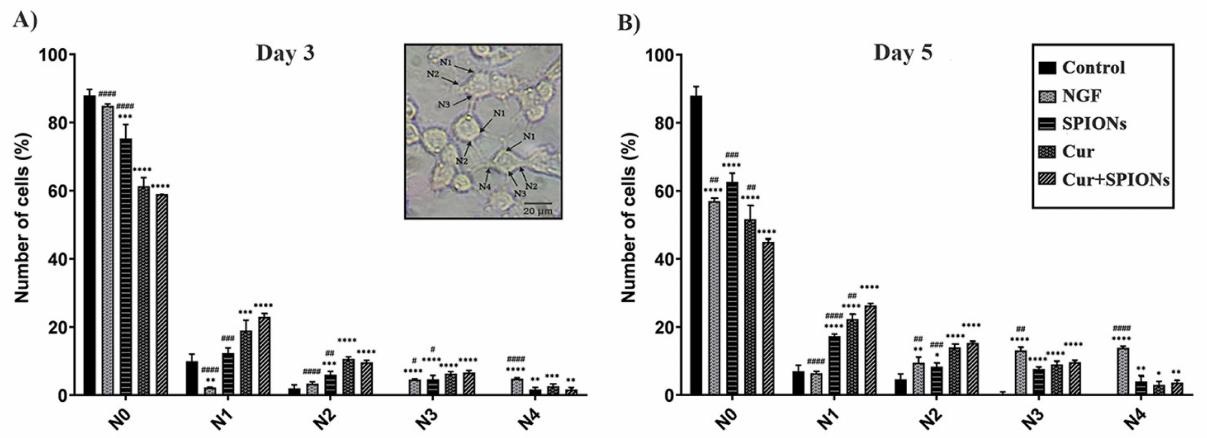
Figure 5. Effects of NGF, SPIONs, curcumin, and Cur+SPIONs on neurite outgrowth in PC12 cells. The number of neurites originating from the soma ( A ) 3 days and ( B ) 5 days after treatment with NGF (50 ng/mL), SPIONs (20 µ g/mL), curcumin (20 µ M), and Cur+SPIONs and the concentration of Cur was 20 µ M in each combination Cur+SPIONs, and the concentration of SPIONs was also 20 µ g/mL. Arrowhead indicates the number of neurites originating from the soma in cells treated with Cur+SPIONs. (#, * p < 0.05, ##, ** p < 0.01, and ###, ***, ####, **** p <